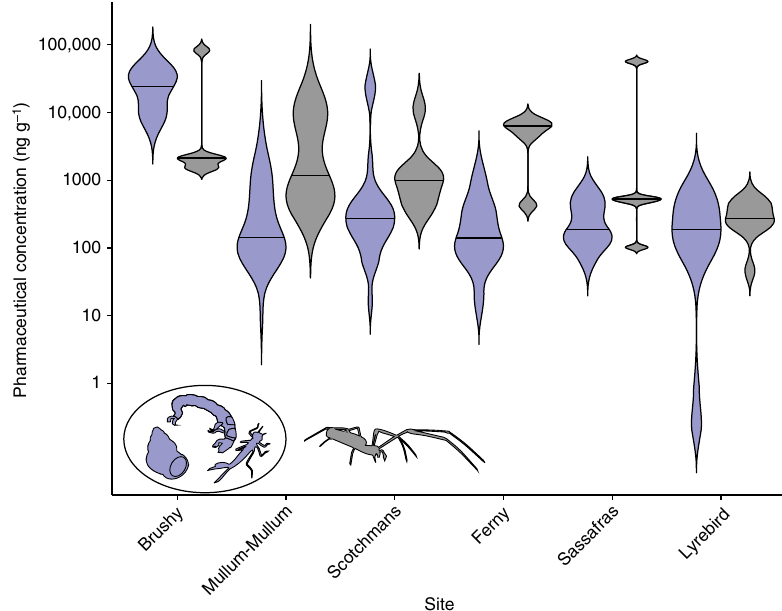
Fig. 2 Pharmaceutical concentrations in benthic aquatic invertebrates and riparian spiders. Total pharmaceutical concentration (ng g − 1 dry weight) in aquatic invertebrates (purple) and riparian web-building spiders (dark grey) for each study site, arranged in decreasing wastewater in fl uence (indicated by δ 15 N in bio fi lms; Table 1). Violin plots illustrate kernel probability density and horizontal lines within each plot indicate median concentrations (see Methods for additional details on violin plots). The caddis fl y image in this fi gure was adapted from Walters, D.M., M.A. Ford, and R.E. Zuellig. 2017. An open-source digital reference collection for aquatic macroinvertebrates of North America. Freshwater Science 36(4):693 − 697. DOI: 10.1086/694539. The spider image was adapted from a photo by Ryan R. Otter (Middle Tennessee State